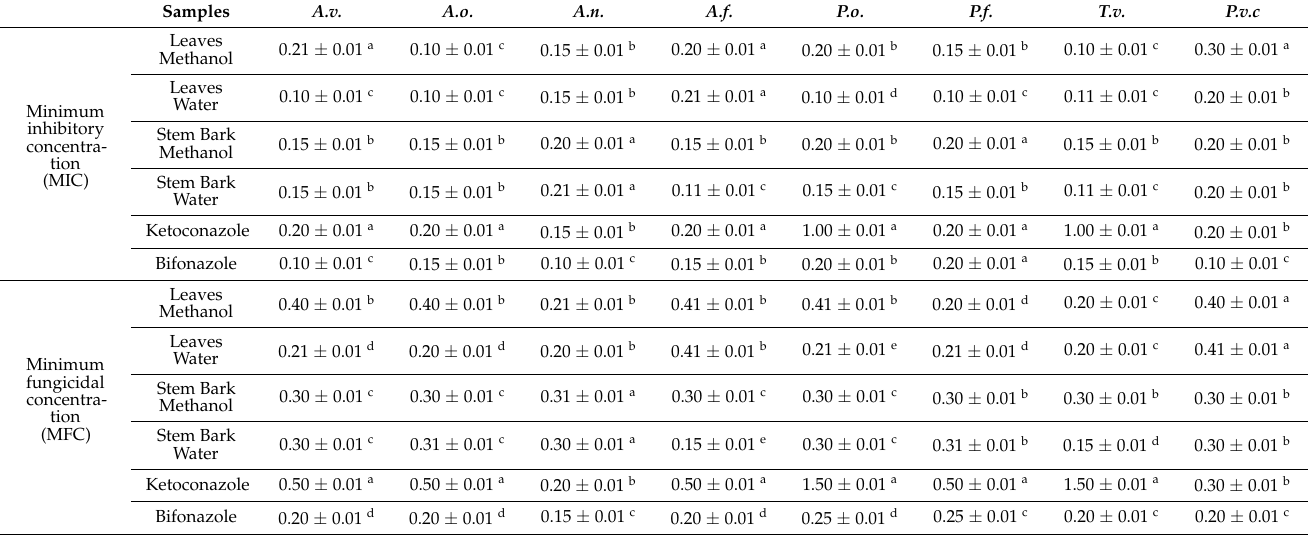
Table 5. Antifungal activity of P. kotschyi samples (mg/mL) *.